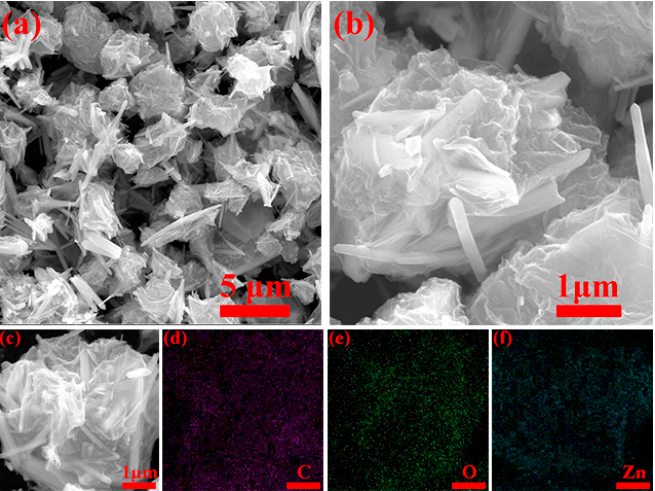
Figure 3. SEM micrographs of ( a – c ) ZnO/graphene composites and ( d – f ) corresponding EDS mapping of ( c ).